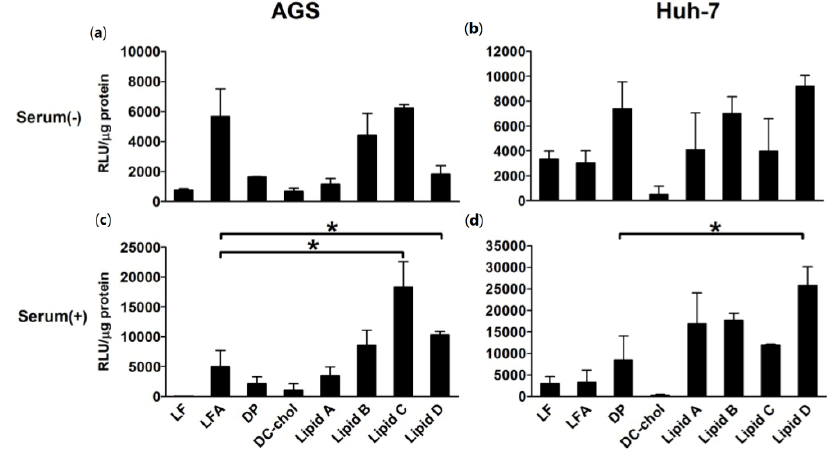
Figure 4. Transfection efficiencies compared to commercial liposomes. The transfection efficiencies of liposomes A – D were compared to that of commercial liposomes at optimal N/P weight ratios (5 for Lipofectin (LF) and Lipofectamine (LFA), and 7 for DOTAP/DOPE (DP) and DC–Chol) in AGS ( a , c ) and Huh-7 ( b , d ) cells by using a luciferase assay. The concentration of DNA (0.2 μ g/well) was kept constant. The incubations were performed in the presence ( c , d ) and absence ( a , b ) of serum. Bars represent the mean ± SD of experiments performed in triplicate. * p < 0.05 vs. LFA ( A , C ) and DP ( B , D ).